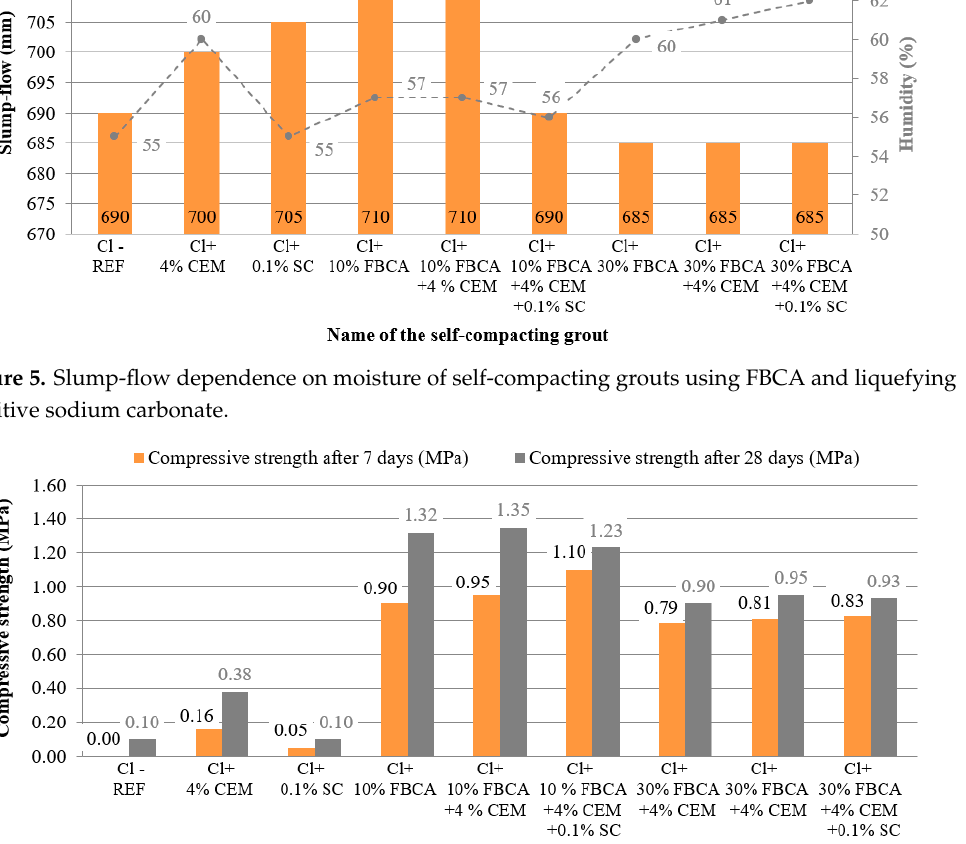
( b ) Figure 7. ( a ) SEM image of the self-compacting grout based on clay soil Cl, 4% CEM and 0.1% SC, ( b ) SEM image of the self-compacting grout based on clay soil Cl, 4% CEM, 10% FBCA, and 0.1% SC.